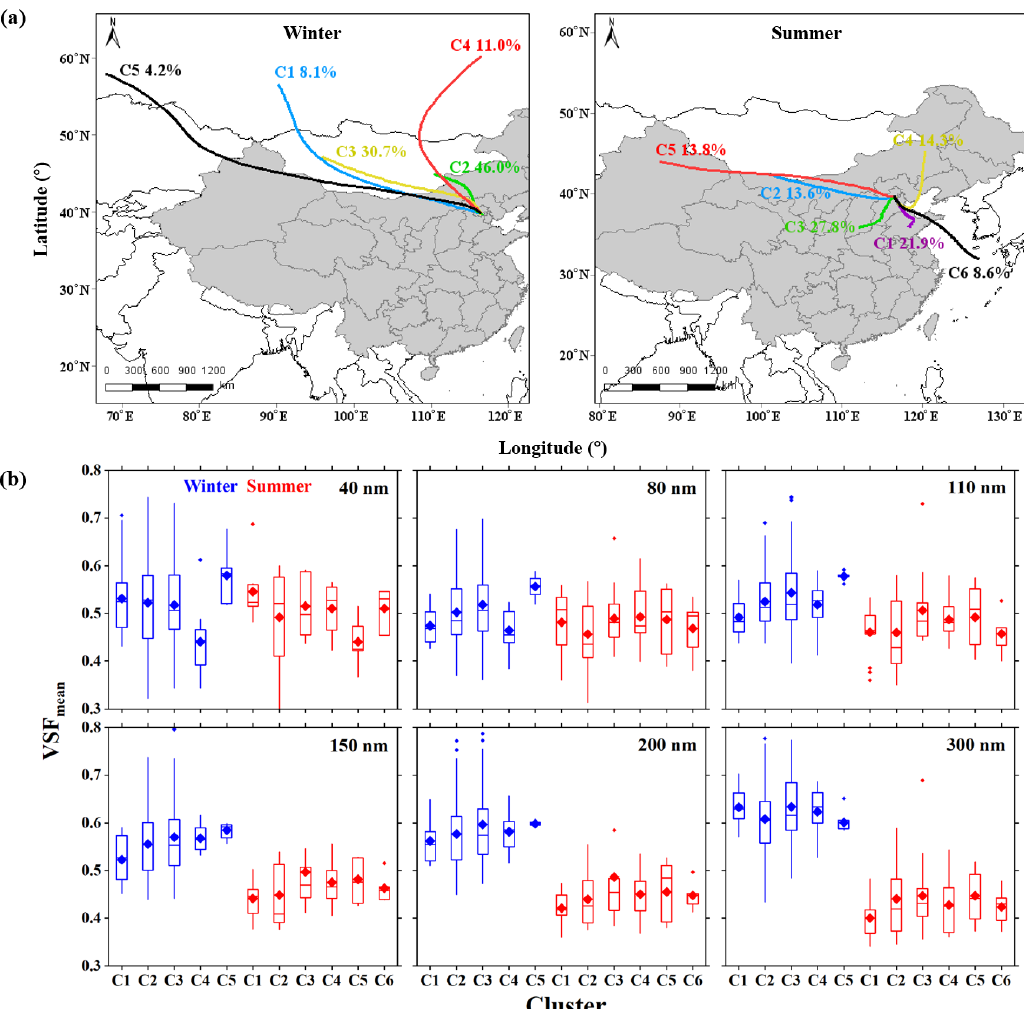
Figure 7. (a) The 72h back trajectories arriving at the Nanjiao site during the winter (left) and summer (right) periods. C1–C6 represent Cluster 1–Cluster 6 respectively. The percentages present the relative occurrences. (b) Box diagram for the mean volatility shrink factor (VSF mean ) of all selected diameter particles (40–300nm) from different clusters during the winter (blue) and summer (red) periods. The horizontal line in the block diagram represents the median, the diamond represents the mean, the upper and lower borders represent the 25th and 75th percentiles, and the upper and lower borders of the dotted vertical line represent the 10th and 90th